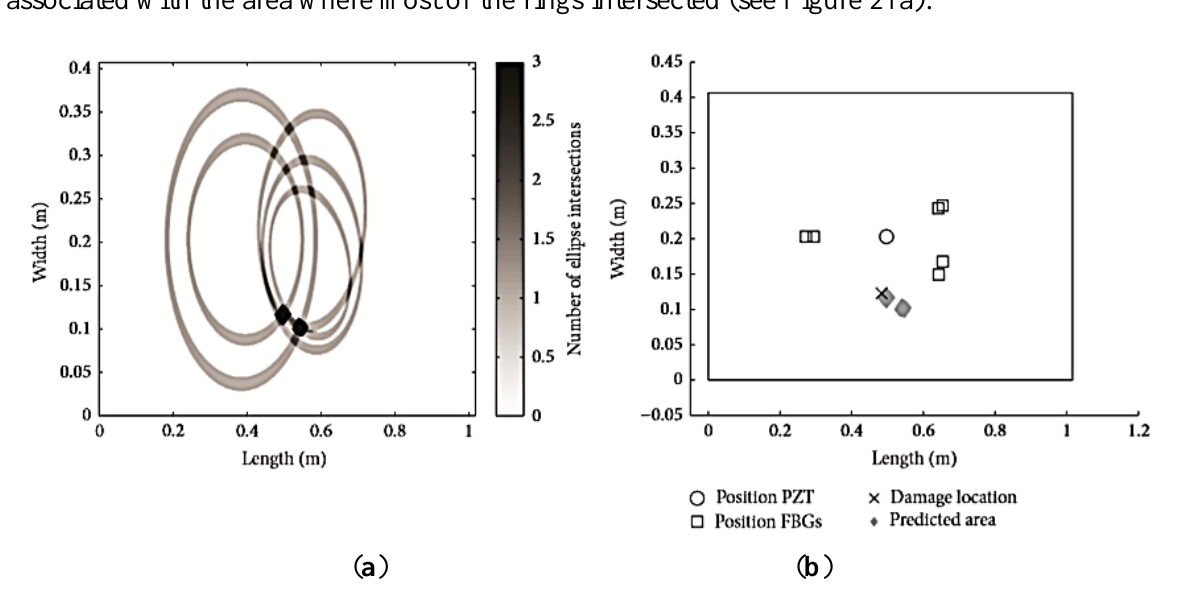
Figure 21. ( a ) Intersection of the calculated ellipses; ( b ) comparison between the actual and predicted damage location